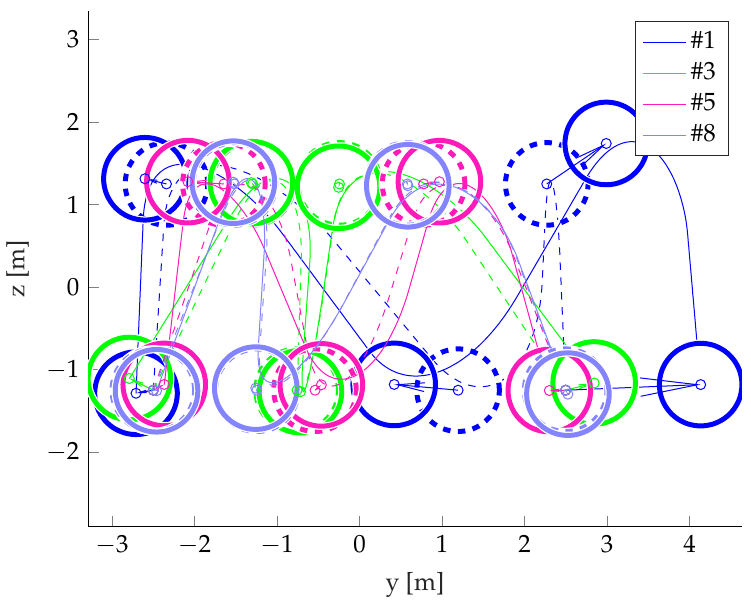
Figure 18. Comparison between the initial and final trajectory for selected cases. The dashed lines represent the initial trajectory, the solid lines the final trajectory, and the dashed and solid circles represent the initial and final acceptance circles, respectively.